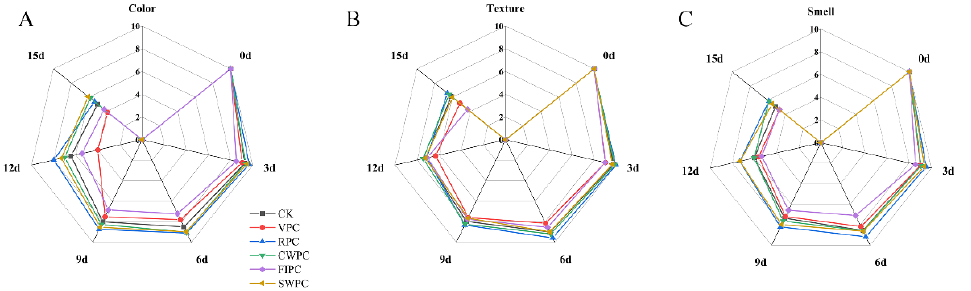
Figure 3. Sensory changes in yellow peaches with different precooling methods during cold storage: ( A ) color; ( B ) texture; ( C ) smell. The abbreviations CK, RPC, CWPC, SWPC, FIPC, and VPC in the figure correspond to control group, refrigerator precooling, cold-water precooling, strong-wind precooling, fluidized-ice precooling, and vacuum precooling, respectively.